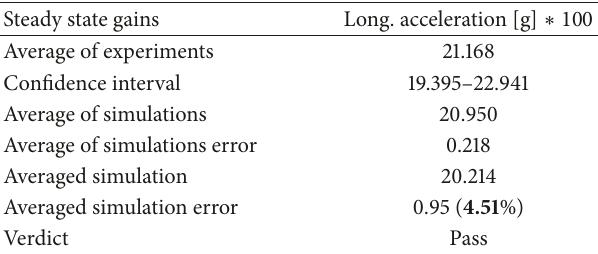
Table 10: Validation results Maneuver Long II: steady-state gains.